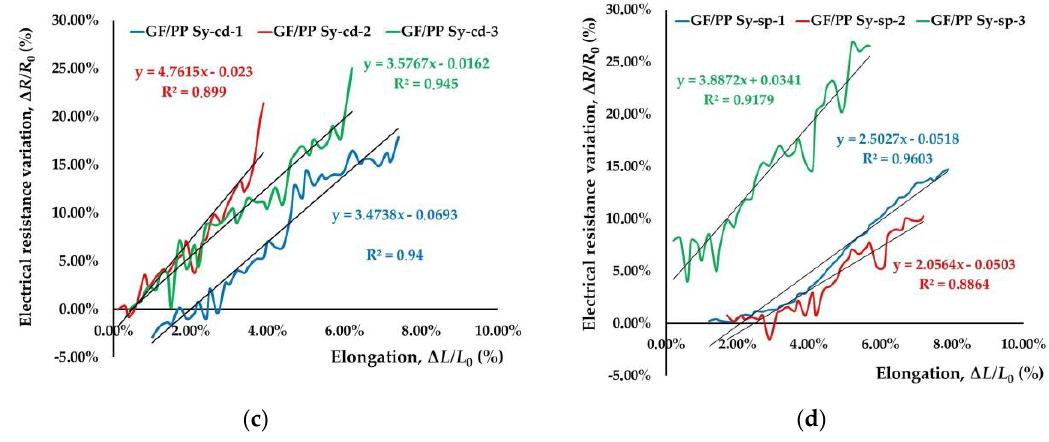
Figure 10. Electromechanical tests of GF/PP sensors developed by: ( a , c ) 8% PEDOT:PSS B/C drops, ( b , d ) silver drops added after copper wires insertion around conductive coated yarn.